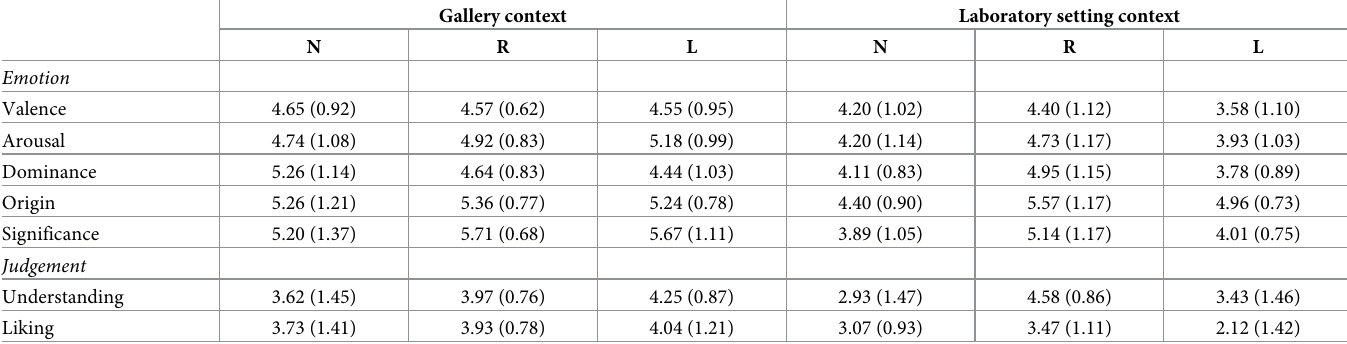
Table 1. Means and standard deviations (presented in parentheses) of aesthetic emotion on the dimensions of valence, arousal, dominance, origin, subjective signif- icance, and of aesthetic judgement on the dimensions of understanding and liking in each group.